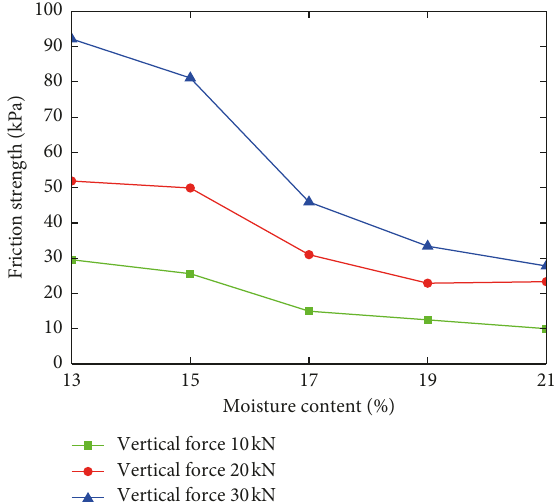
Figure 8: Friction strength of paint on the concrete surface and soil for different moisture contents.